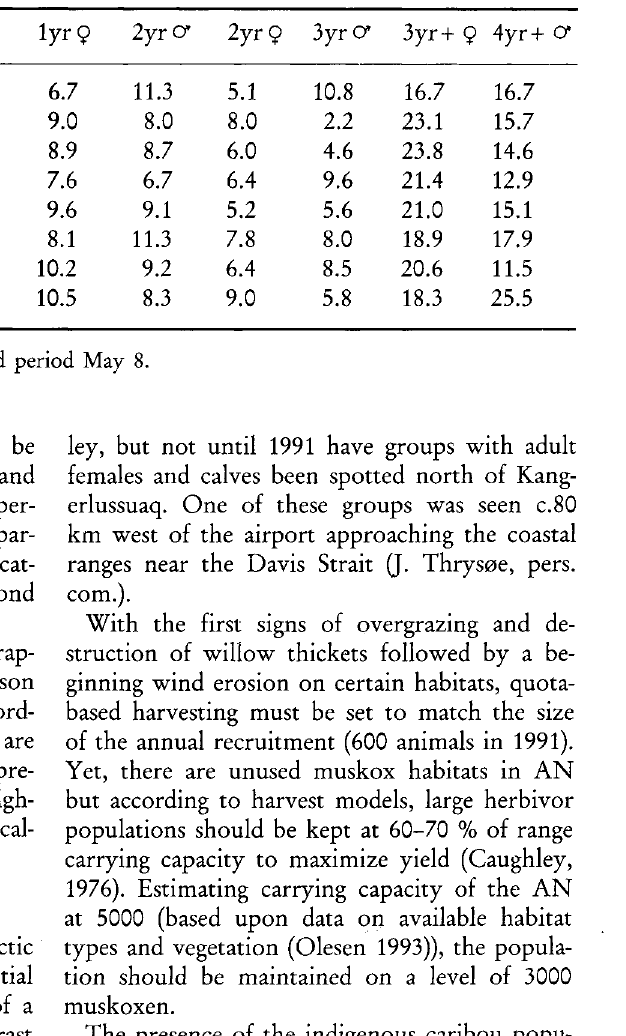
Table 3. Sex and age composition of the Angujaartorfiup Nunaa muskox population 1988-1991. (% of obser ved